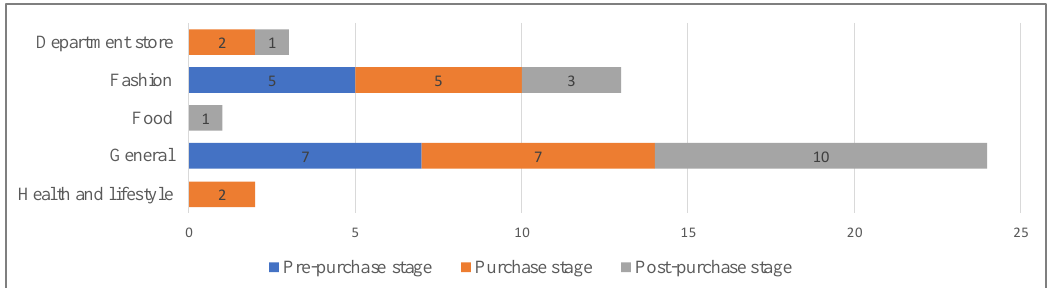
analyzed in depth in each sector to gauge whether the information can be corroborated in specific retail sectors.